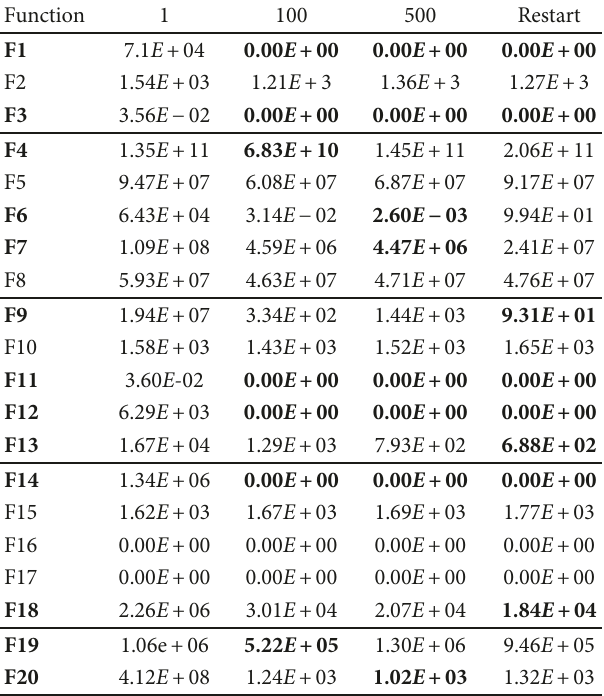
Figure 7: Convergence curves of active child populations in the 29th subproblem when optimizing F10 . Table 6: Performance comparison with di ff erent M . Bold values denote the best performance. Bold function number indicates that in such function the maximal value is larger than 1.5 times the minimal